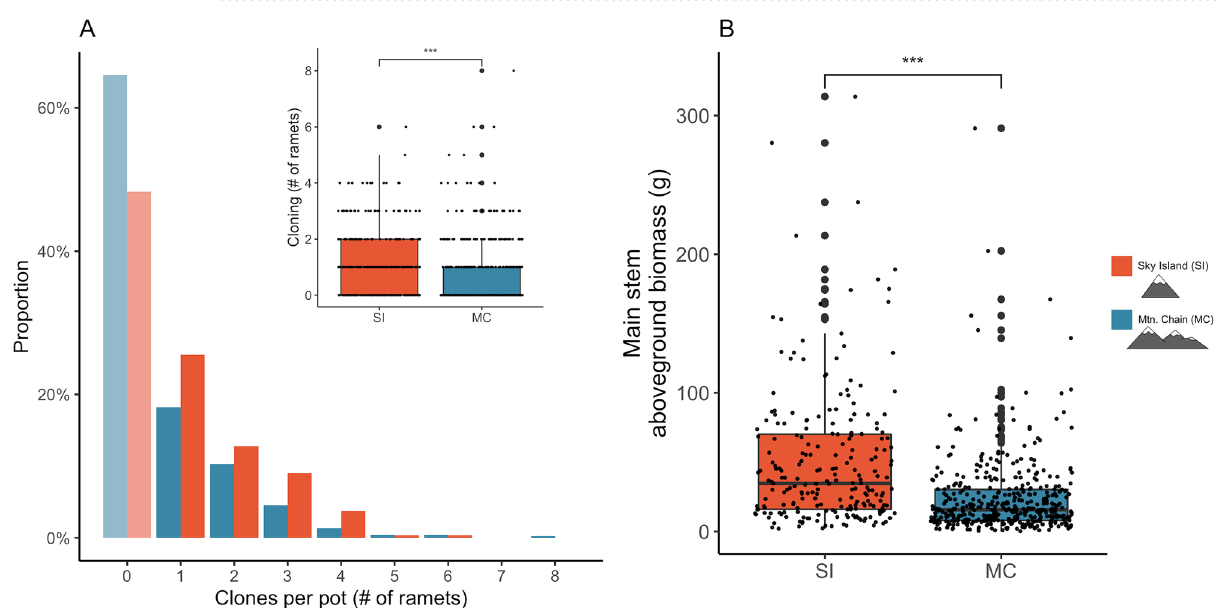
Figure 3. Functional traits of Populus angustifolia diverge between sky islands (SI) and mountain chains (MC) when grown in a common environment. ( A ) The mean number of clonal ramets and ( B ) aboveground biomass are significantly higher on SI than MC. Panel ( A ) shows the normalized mass of cloning ramets (#) on SI (orange) and on MC (blue), separately. Each orange bar shows the proportion of ramets from trees from SI with a given cloning ramet number (x-axis), blue bars correspond to the same for MC; all bars in each color add up to 1. The inset is a box and whisker plot representative of these data. In each box and whisker plot, black circles denote genotype replicates (n = 193 genotypes on MC; n = 57 genotypes on SI). Asterisks denote a significant difference (* p <